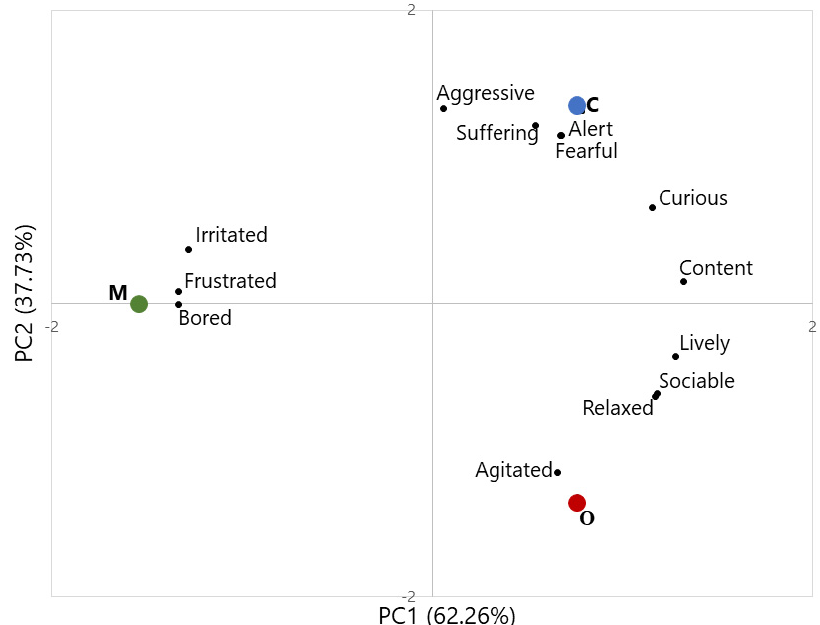
Figure 2. Scores plot of the principal component analysis performed on using QBA (qualitative behavior analysis) results. Legend: red = farm O (organic-certified farm); green = farm M (mountain farm); blue = farm C (conventional lowland farm); black = descriptors.